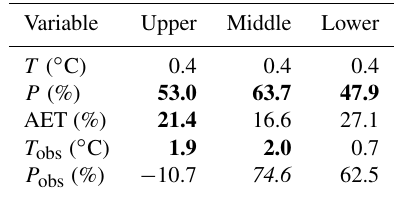
Table 2. Mann–Kendall trends from 1980 to 2010 of the simulated temperature ( T ), precipitation ( P ), actual evapotranspiration (AET) and observed temperature ( T obs ), and precipitation ( P obs ). The bold and italic numbers are significant at p <0.01 and p <0.05, respec-